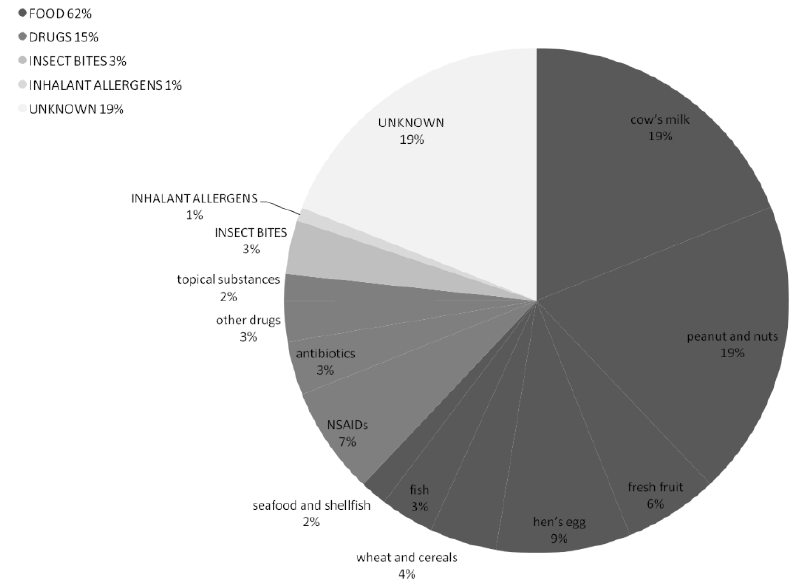
Figure 3. Suspected triggers of the anaphylactic reactions among 116 patients referred to the PED. Most of the episodes were likely triggered by foods ( n = 72, 62%), mainly cow’s milk and nuts, followed by drugs in 17 (15%) reactions. In 19% of the events ( n = 22), it was not possible to state the etiological agents by the patients’ medical history.